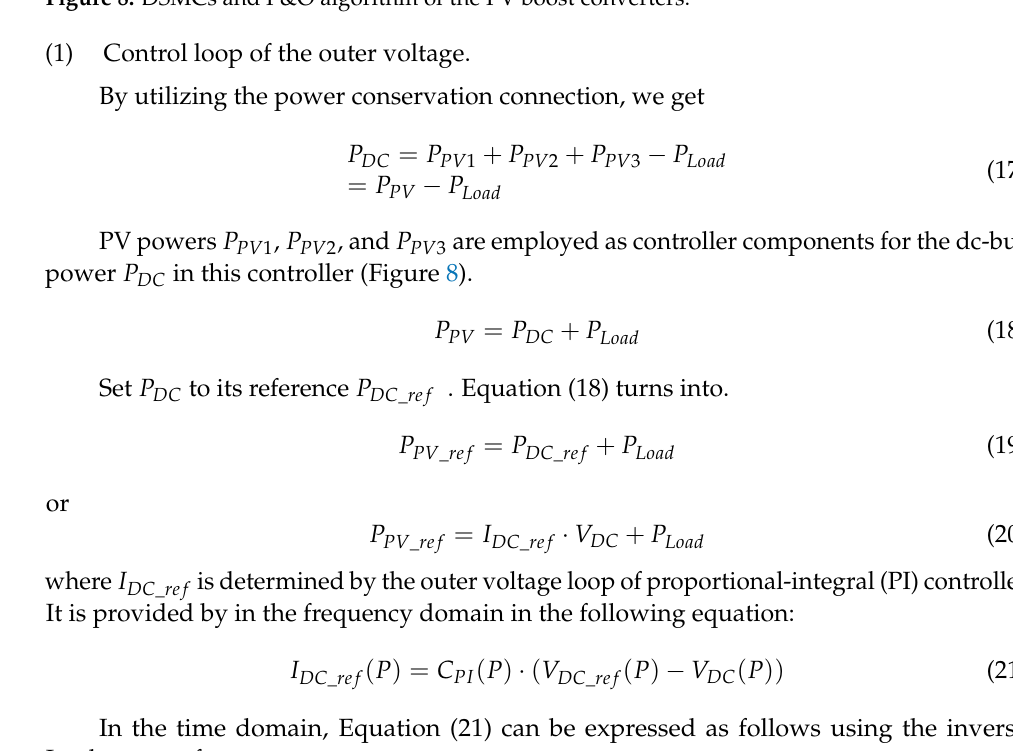
Figure 8. DSMCs and P&O algorithm of the PV boost